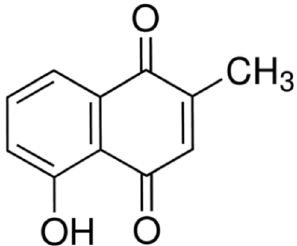
Figure 1. Chemical structure of plumbagin.